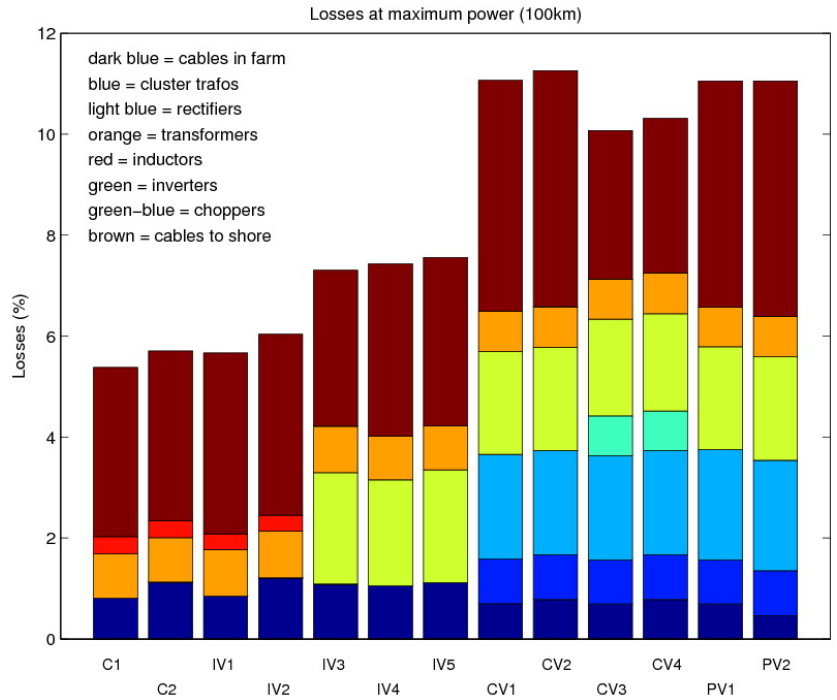
Figure 9 . Losses at rated power divided over the system